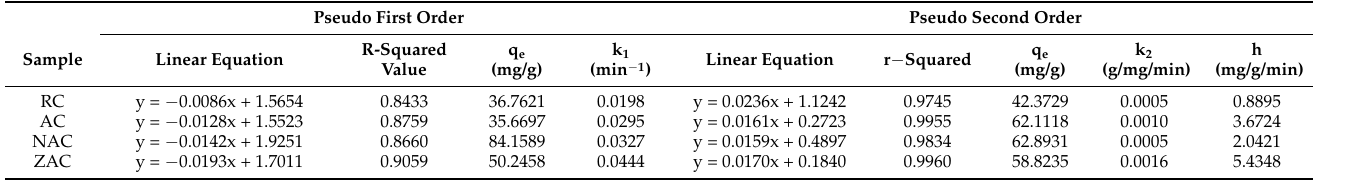
Figure 11. Plot of log (qe − qt) versus time t for the pseudo-first-order model for the adsorption of ofloxacin onto all types of cassava stem adsorbents. Table 9. Pseudo-first-order and pseudo-second-order kinetic parameters for the adsorption of ofloxacin onto all types of cassava stem